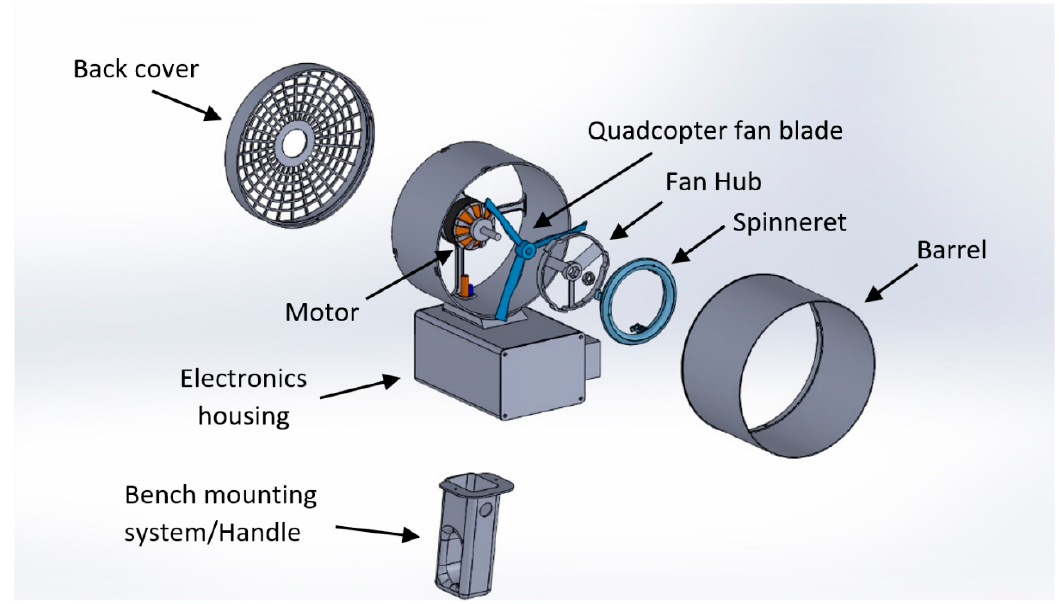
Figure 1. Exploded view of the Handheld Device (HD), showing its main components.